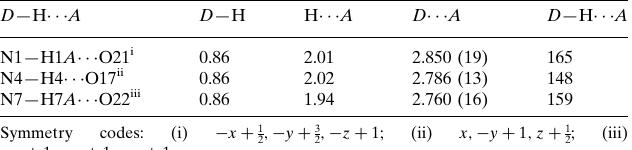
Hydrogen-bond geometry (A˚ , (cid:4)